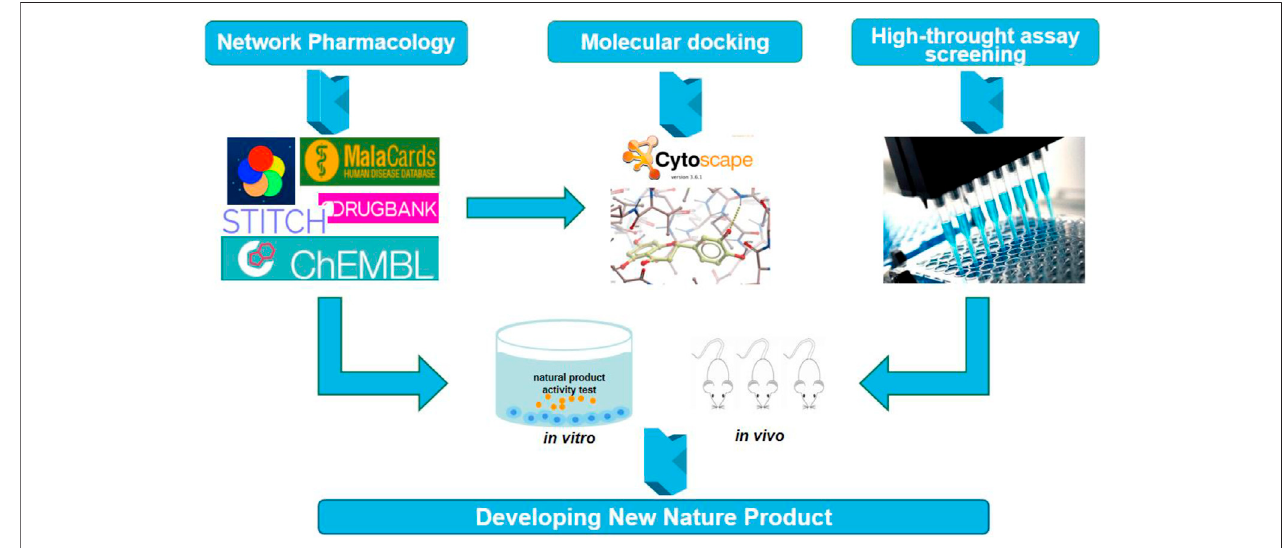
FIGURE 1 | Novel strategies applied to developing nature product